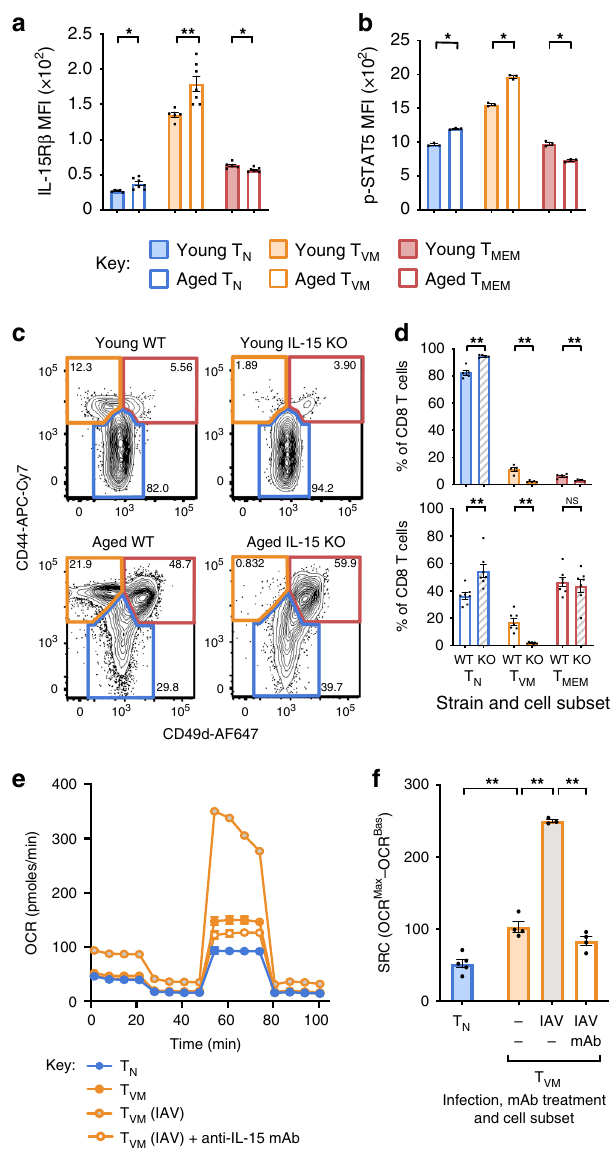
Fig. 5 High IL-15 sensitivity in T VM cells increases with age and mediates increased SRC. a IL-15R β MFI directly ex vivo from individual mice ( n = 5 – 7) or b pSTAT5 MFI after 15 min of stimulation with IL-15 in vitro on sorted T N , T VM and T MEM cells from young or aged mice ( n = 3). c Representative dot plots for CD8 + T cells gated on T N (CD44 lo ), T VM (CD44 hi CD49d lo ) and T MEM (CD44 hi CD49d hi ) cells (frequency of CD8 + T cells indicated) and d frequency of CD8 + T cells in each subset in WT or IL-15 KO mice ( n = 5 for WT and 7 for KO). e OCR for sorted T N , T VM and T MEM cells from young uninfected, IAV-infected and IAV-infected/IL-15 neutralising mAb treated mice and f change in OCR for each sorted subset. Shown is mean± SEM. * Indicates p ≤ 0.05, ** indicates p ≤ 0.01, unpaired t test, data for a , b , e , f are representative of at least 3 individual